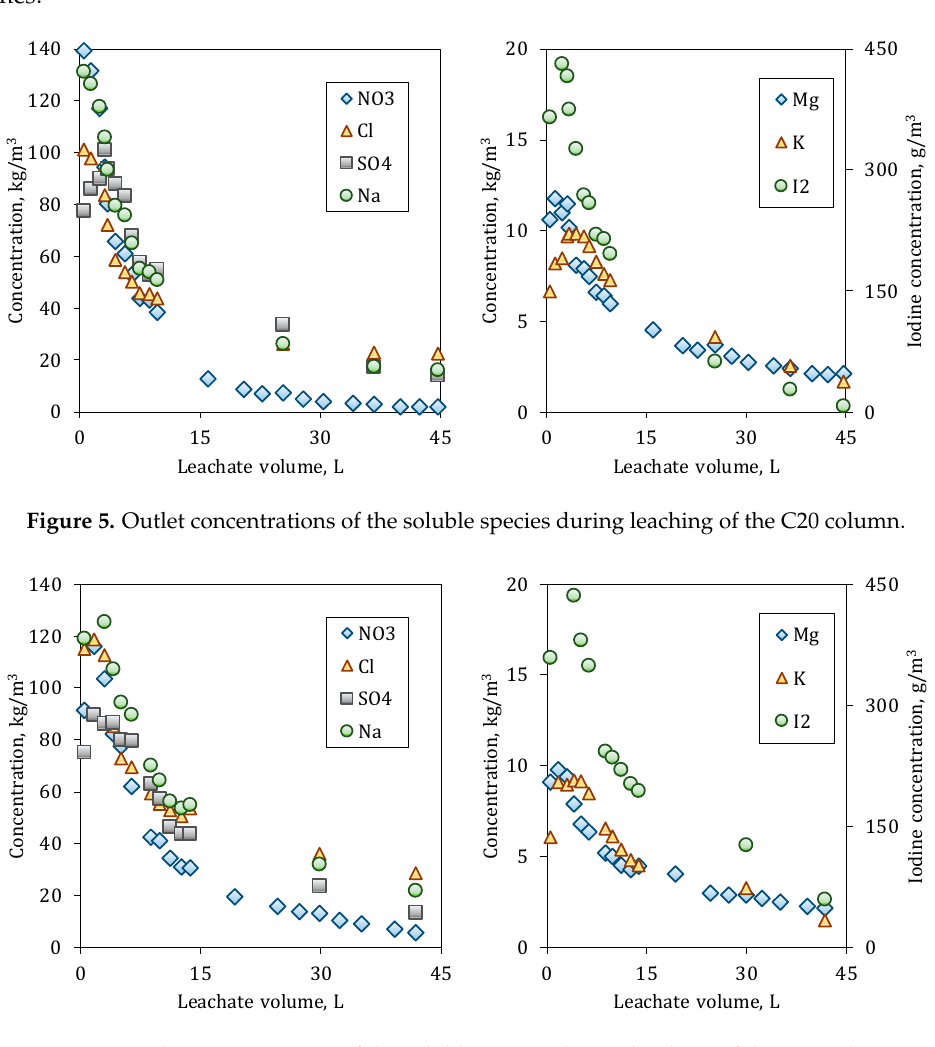
Figure 6. Outlet concentrations of the soluble species during leaching of the C80 column.